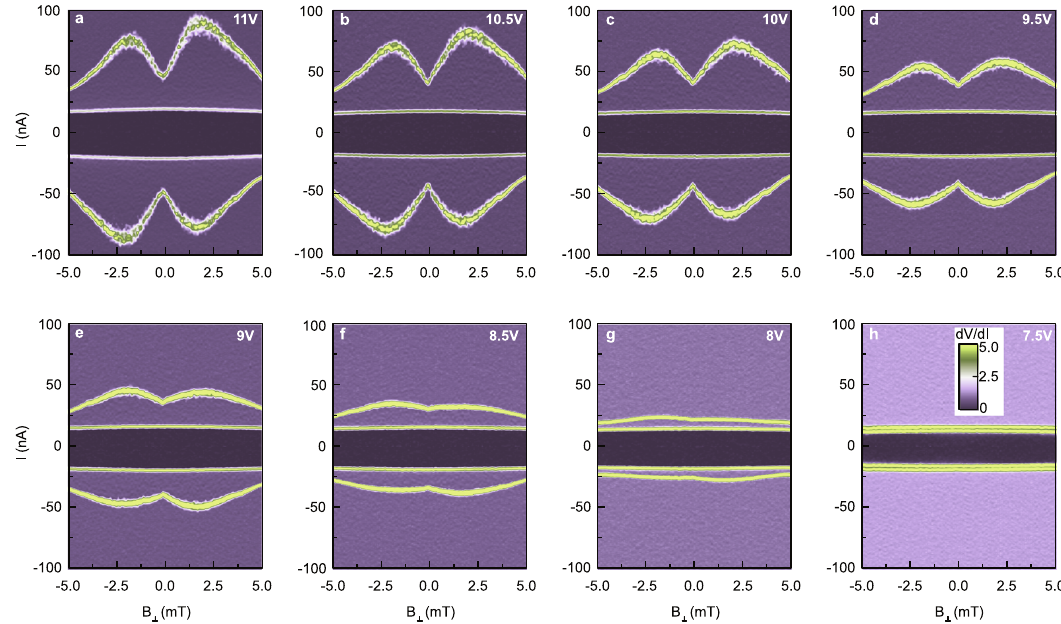
Fig. 3 Gate voltage effect on critical current enhancement. a – h The contour plot of dV / dI as a function of the current and out-of-plane magnetic fi eld measured across the weak link at 20 mK and constant gate voltages between 11 and 7.5